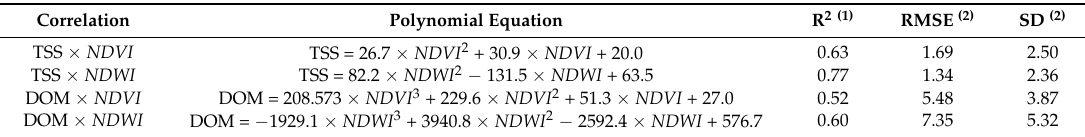
Table 3. Polynomial regression